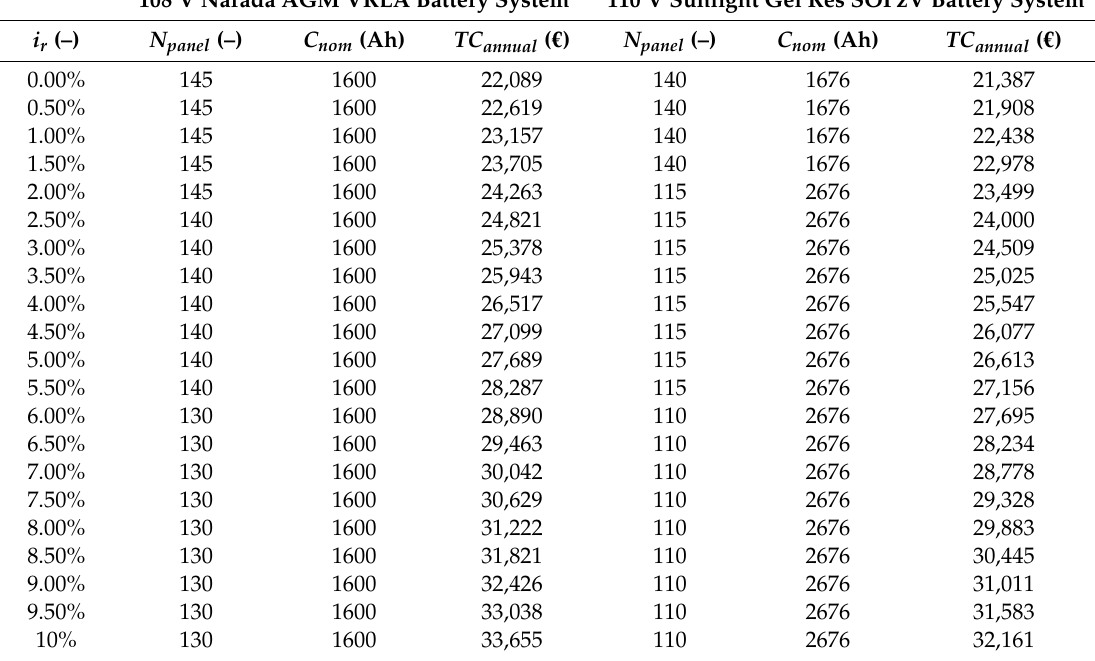
Table 10. Proposed configuration of the SAPV system with a battery system (PV population N panel , battery nominal capacity C nom ) with respect to equivalent total equivalent cost TC annual for a di ff erent interest rate without inflation i r , for the 108 V Narada AGM VRLA battery and for the 110 V Sunlight gel RES SOPzV battery